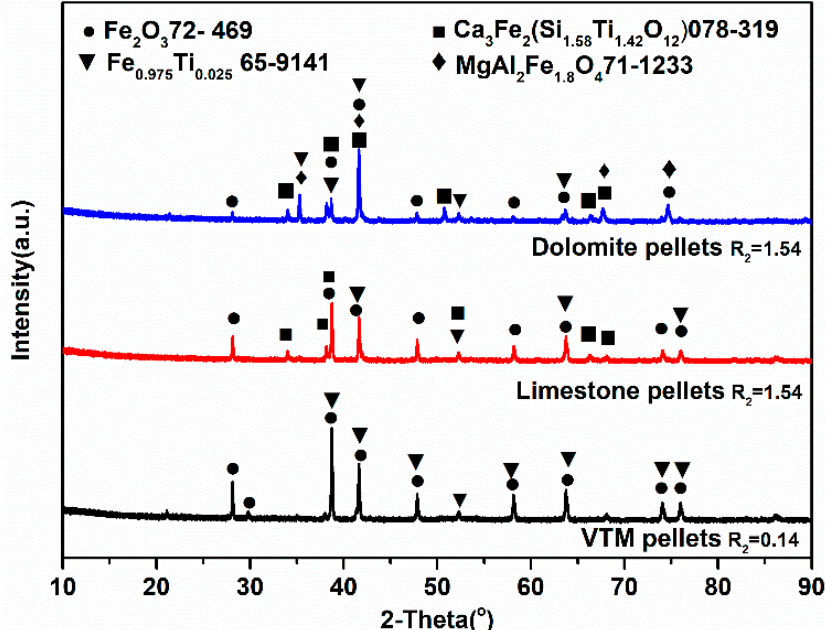
Figure 9. XRD patterns of roasted pellets with different flux types.